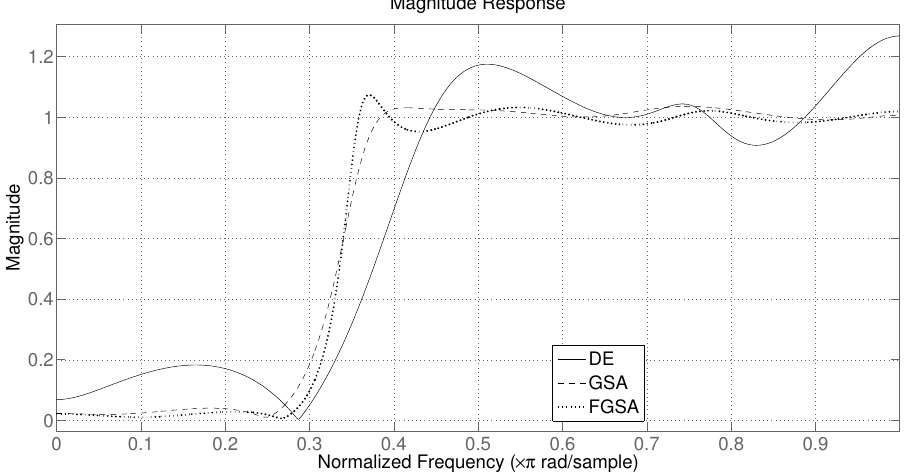
Figure 8. Magnitude response over normalized frequency for 8th order IIR High Pass filter using DE, GSA and FGSA.